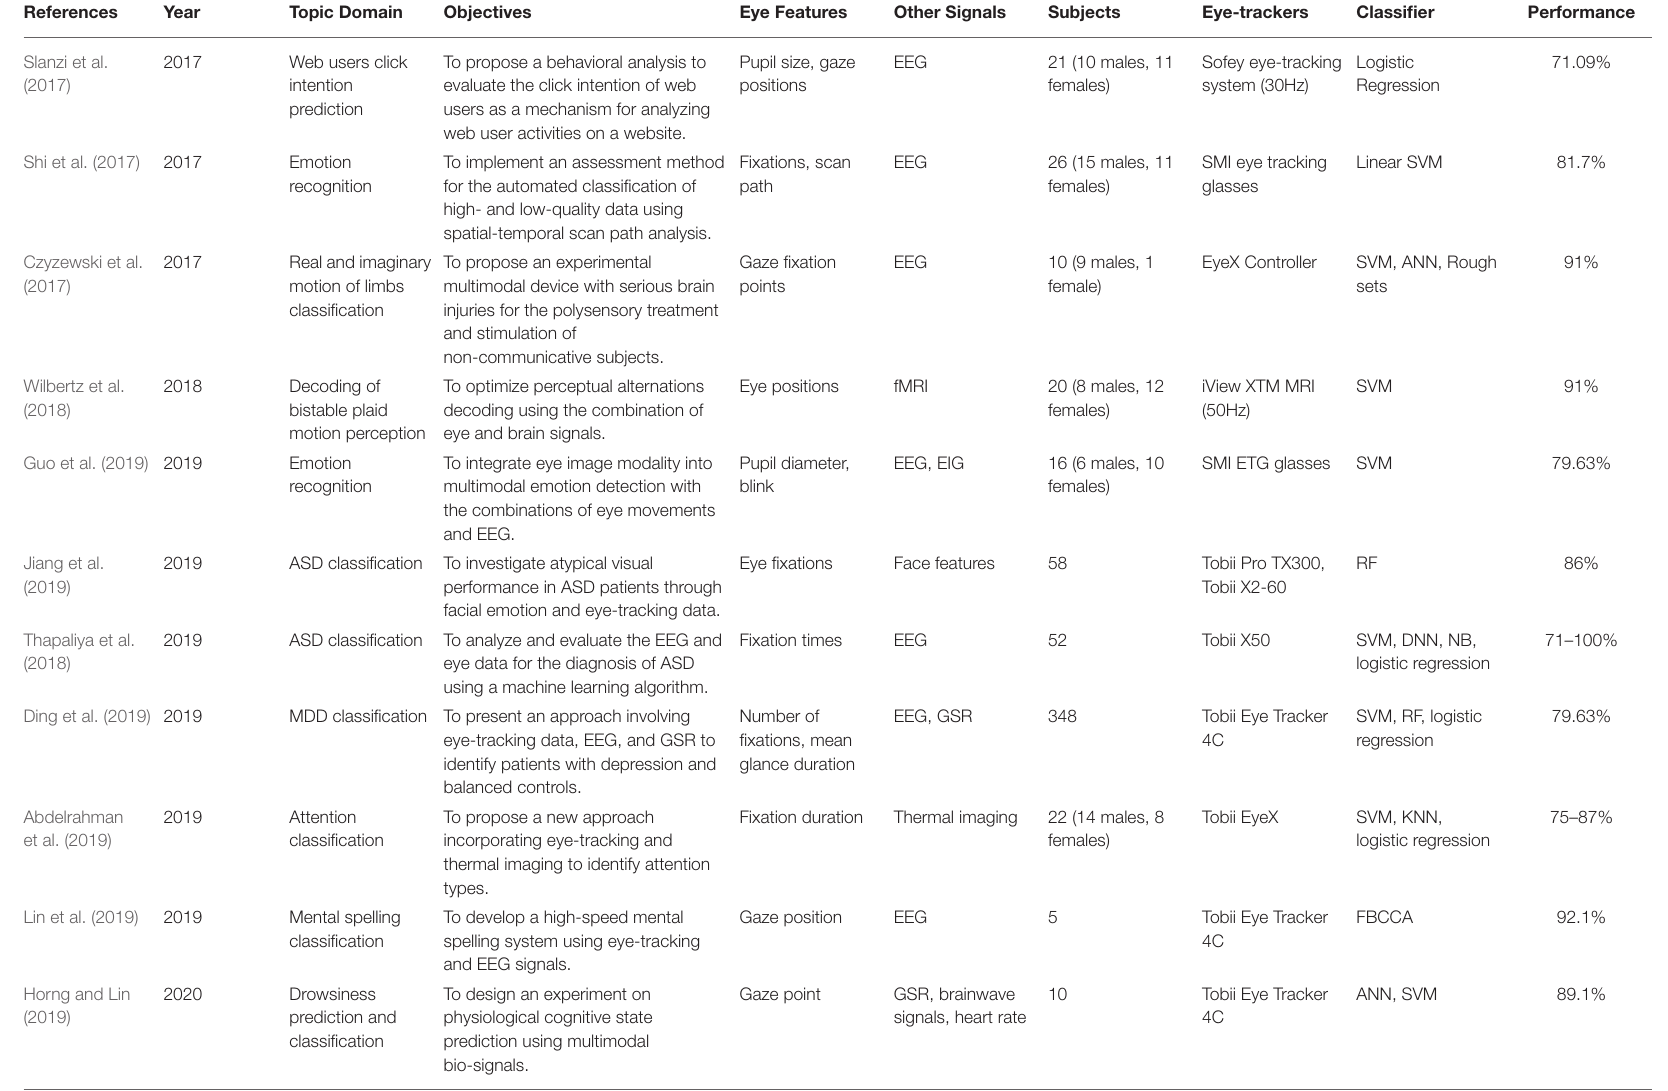
TABLE 2 | Summary of research using eye features with the combination of other